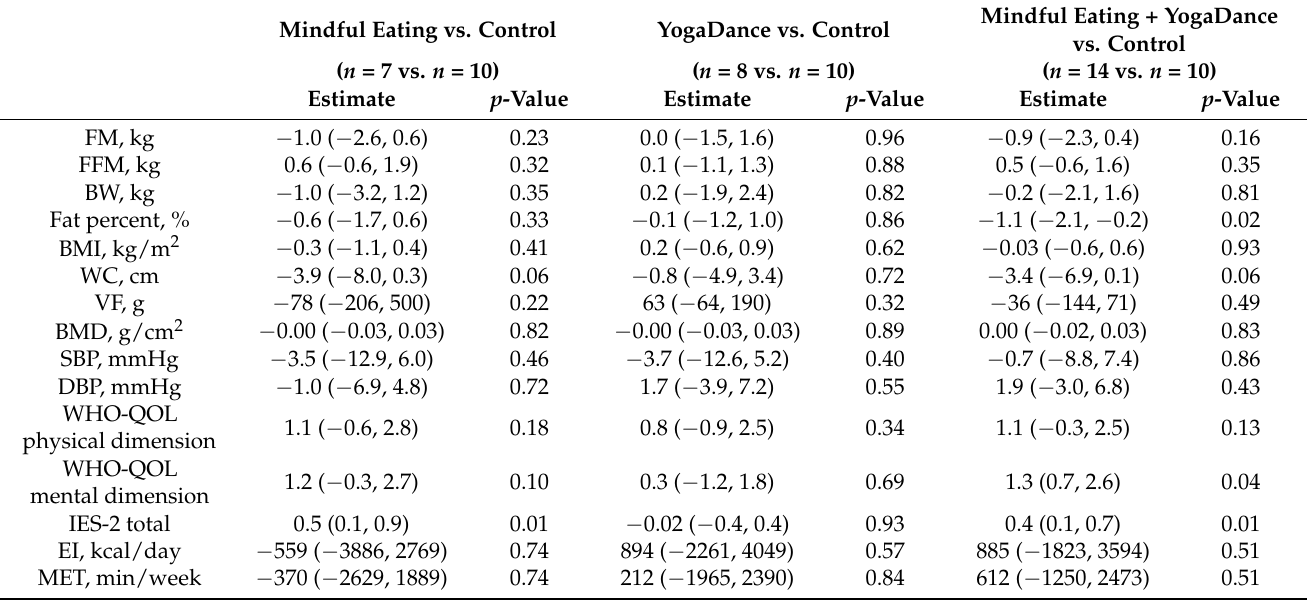
Table 3. Pairwise comparisons of means at the end of the study (after 8 weeks) based on unadjusted complete-case analyses ( n = 39). Mindful Eating vs. Control YogaDance vs. Control